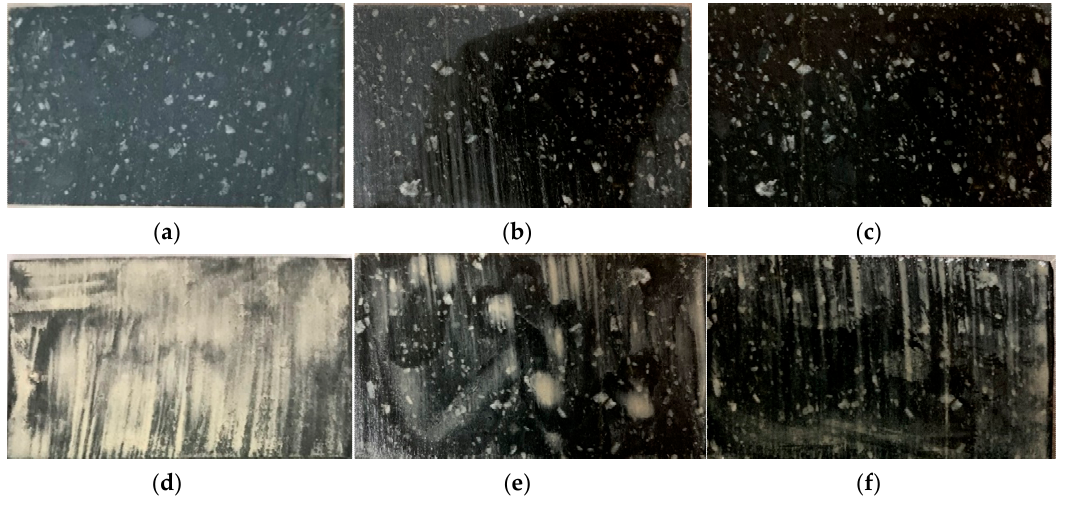
Figure 3. Surface of the aggregates used in this study ( a ) F-00-0, ( b ) F-00-50, ( c ) F-00-100, ( d ) F-15-0, ( e ) F-15-50, ( f ) F-15-100.